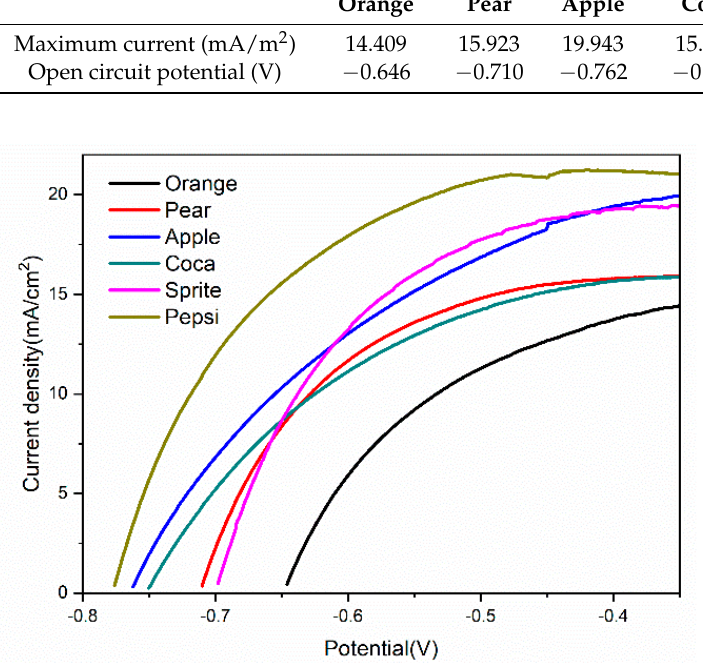
Table 3. Maximum current and open circuit potential of the AFC anode with different sweet drinks as substrate. Juice Drinks Carbonate Beverages Drink Types Orange Pear